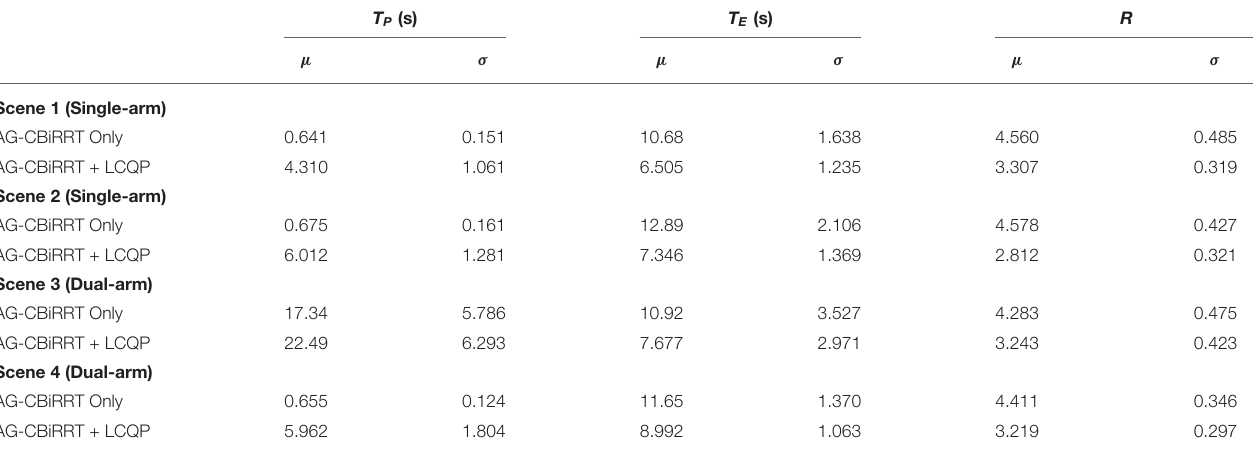
TABLE 4 | Experimental results of robot motion planning under task